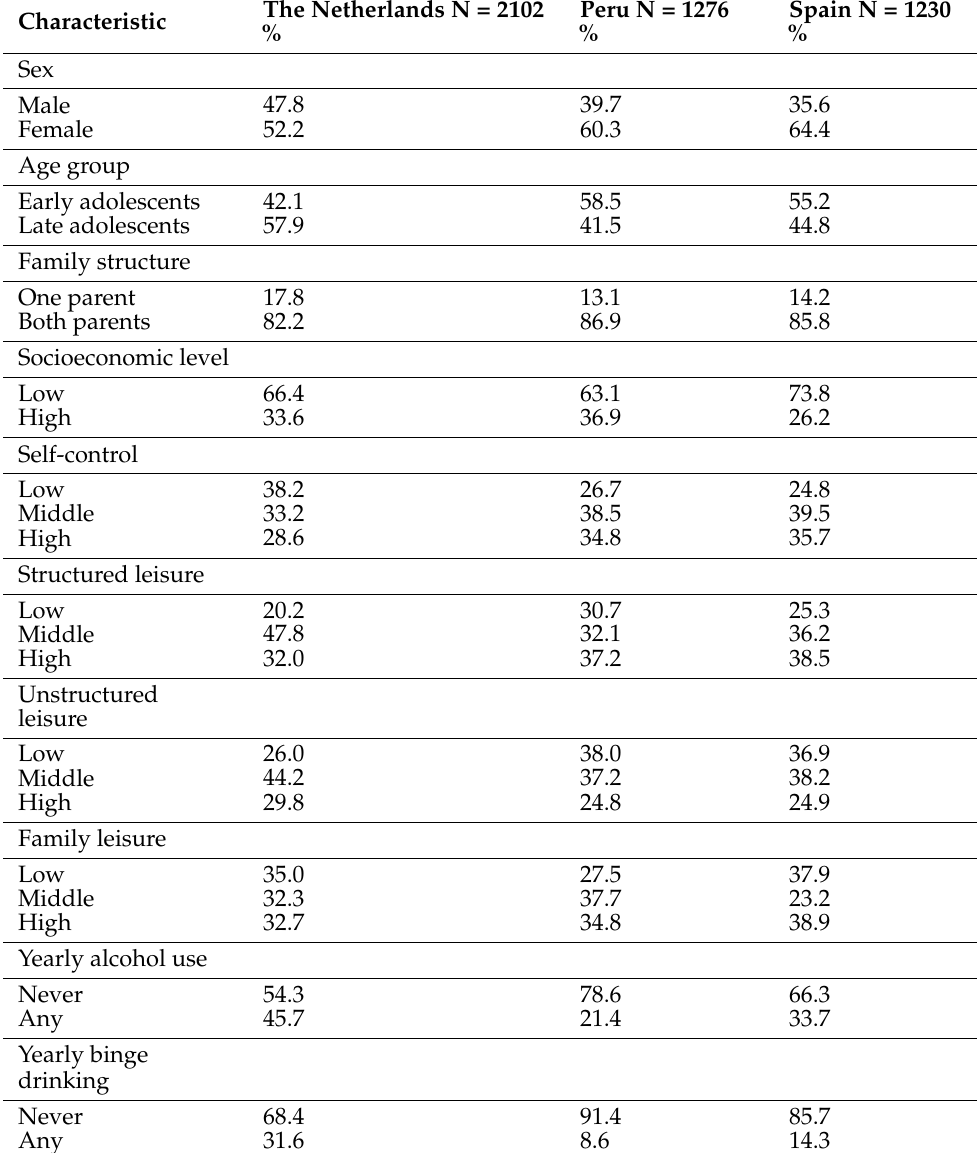
Table 2. Characteristics of the